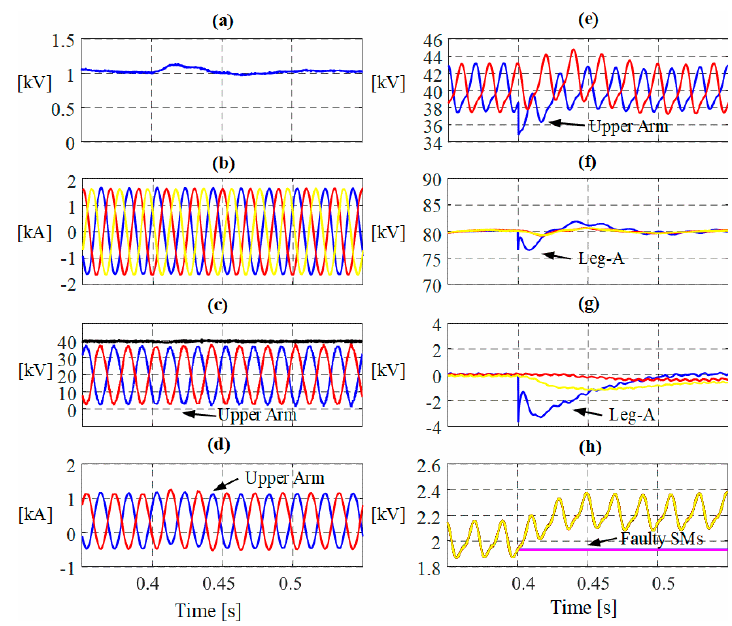
Figure 9. Simulation waveforms of the MMC under SM fault and control scheme-B operates in active power mode: ( a ) dc current, ( b ) ac current, ( c ) leg A upper and lower arm voltages superimposed on its common-mode voltage, ( d ) leg A upper and lower arm currents, ( e ) leg A upper and lower capacitor voltage sums, ( f ) common-mode capacitor voltage sums of three phase-legs, ( g ) differential-mode capacitor voltage sums of three phase-legs, and ( h ) leg A upper arm SM voltages.